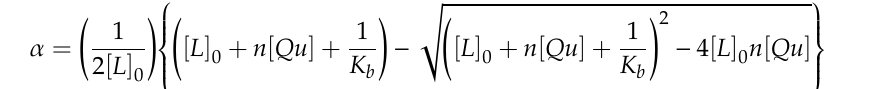
s1. Figure S1. Amount of the released ligands NDI-1-NDI-5 as a function of the volume of washing / releasing solutions. Figure S4. CD spectra of tel26, cmyc and ds27 in the absence and presence of increasing amount of NDI-9. Figure S5. Melting curves for tel26, cmyc and ds27 in the absence and presence of 6 equivalents of NDI-5 or NDI-9. Figure S6. CD spectra of tel26 in the absence and presence of increasing amounts of NDI-5 and melting curve for tel26 / NDI-5 mixture (1:6). Figure S7. CD spectra of cmyc and ds27 in 10 mM Tris-HCl, 10% DMSO bu ff er (pH 7). Figure S8. Fluorescence spectra of NDI-5 in the absence and presence of tel26, cmyc and ds27. Figure S9. Fluorescence experiments for NDI-9. Additional data, i.e., HPLC purity data, ESI-MS spectra and 1